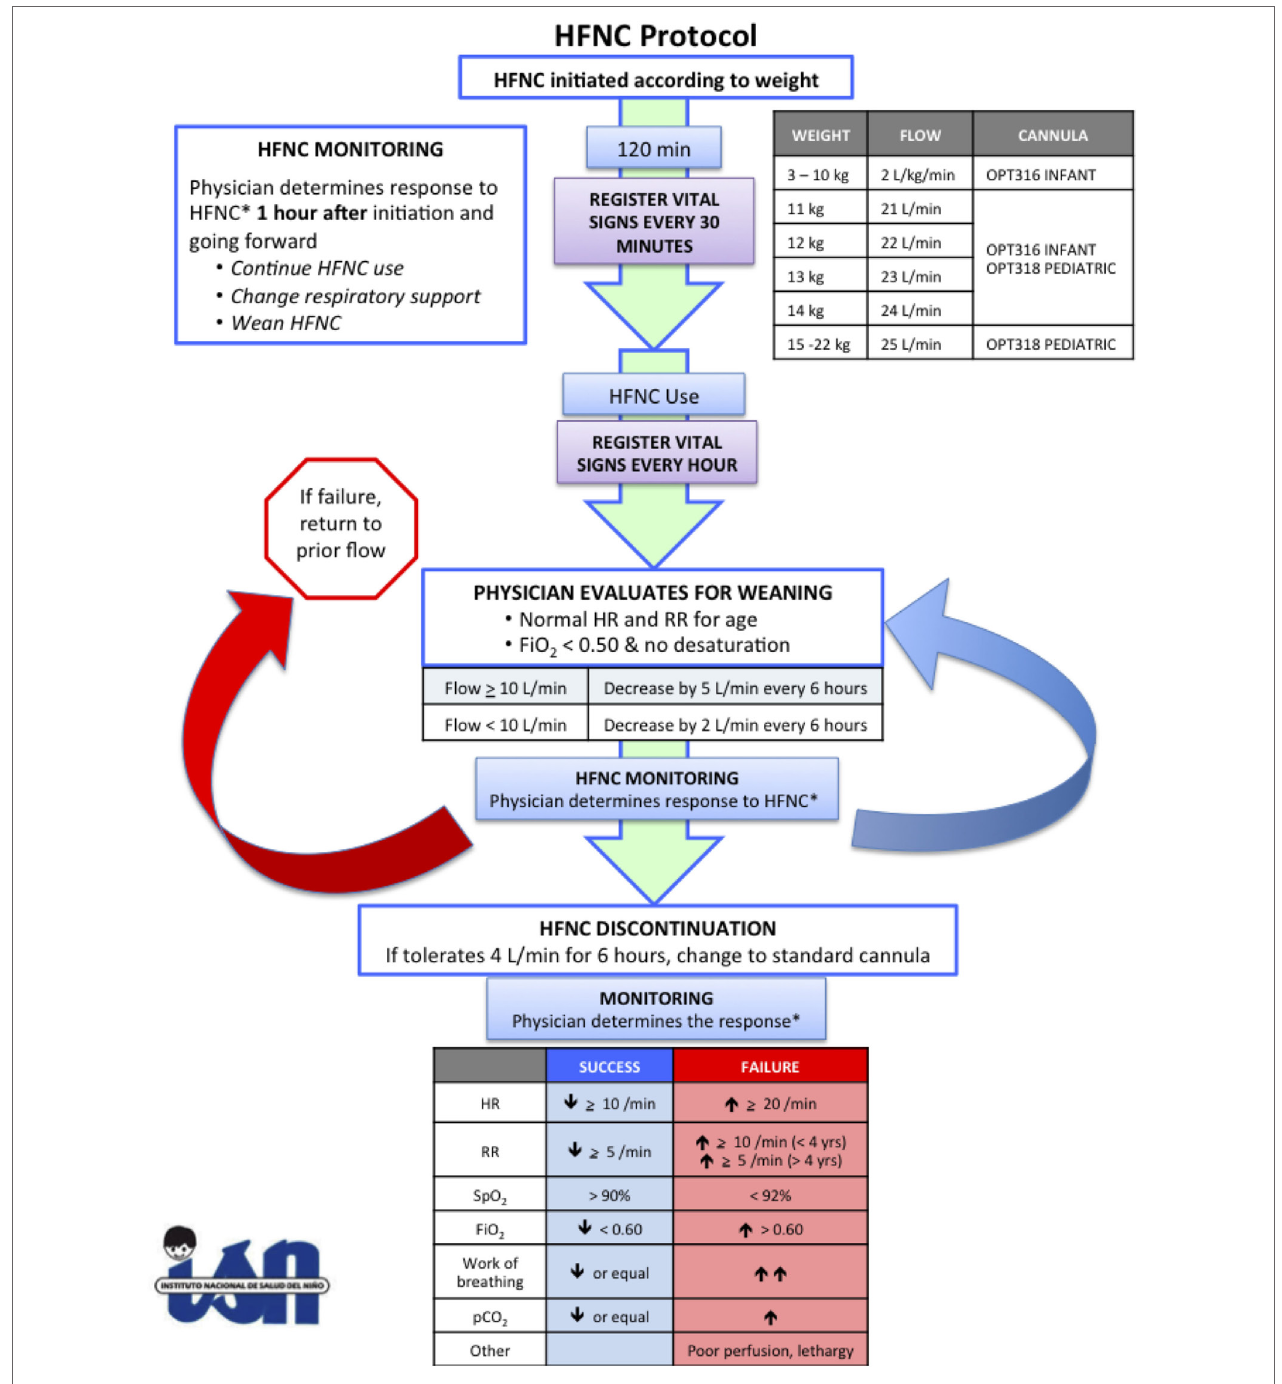
FiGUre 1 | High flow nasal cannula protocol at Instituto Nacional de Salud del